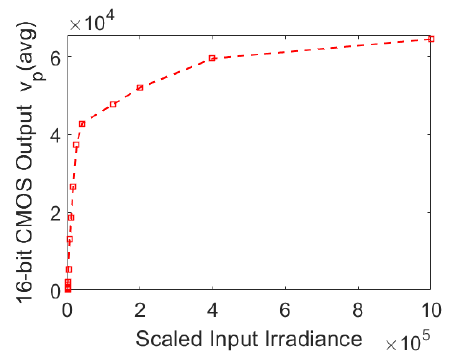
Fig. 1. Experimental CRF .